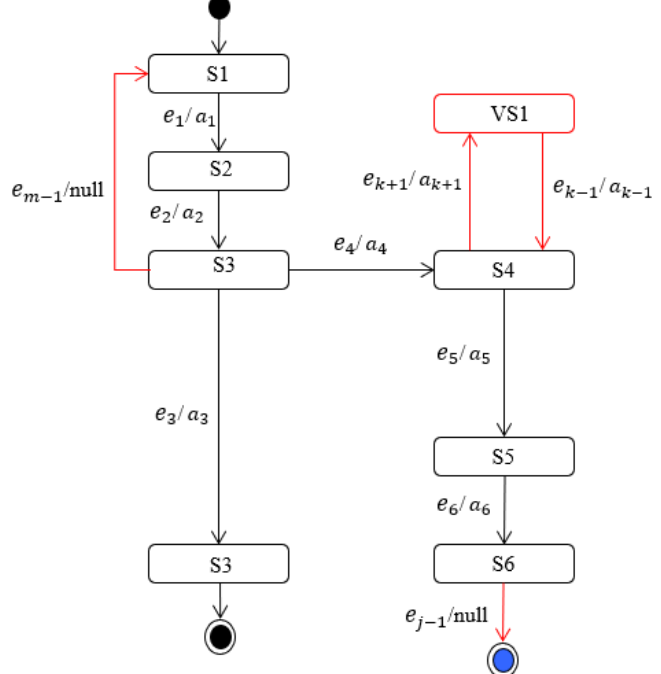
Figure 6. Example of an R-STD for environmental variabilities.